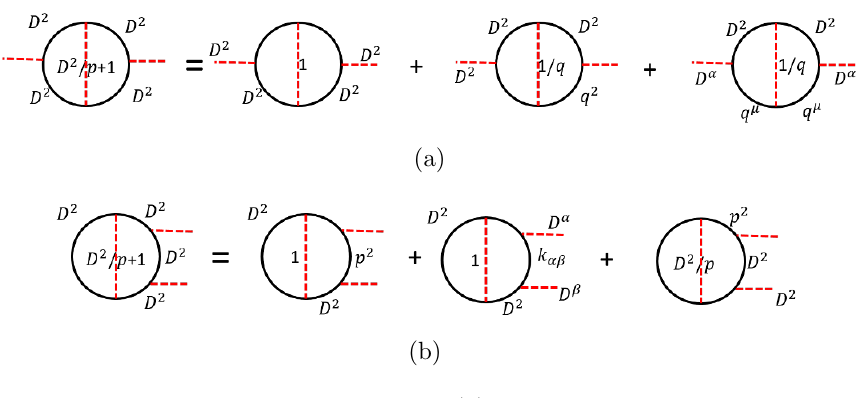
Figure 21. Type ( a )